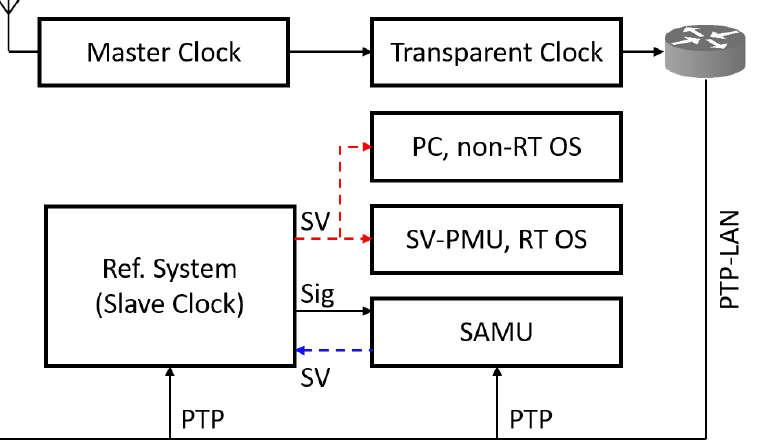
Figure 8. Network topology of the measurement setup for the assessment of the publishing rate